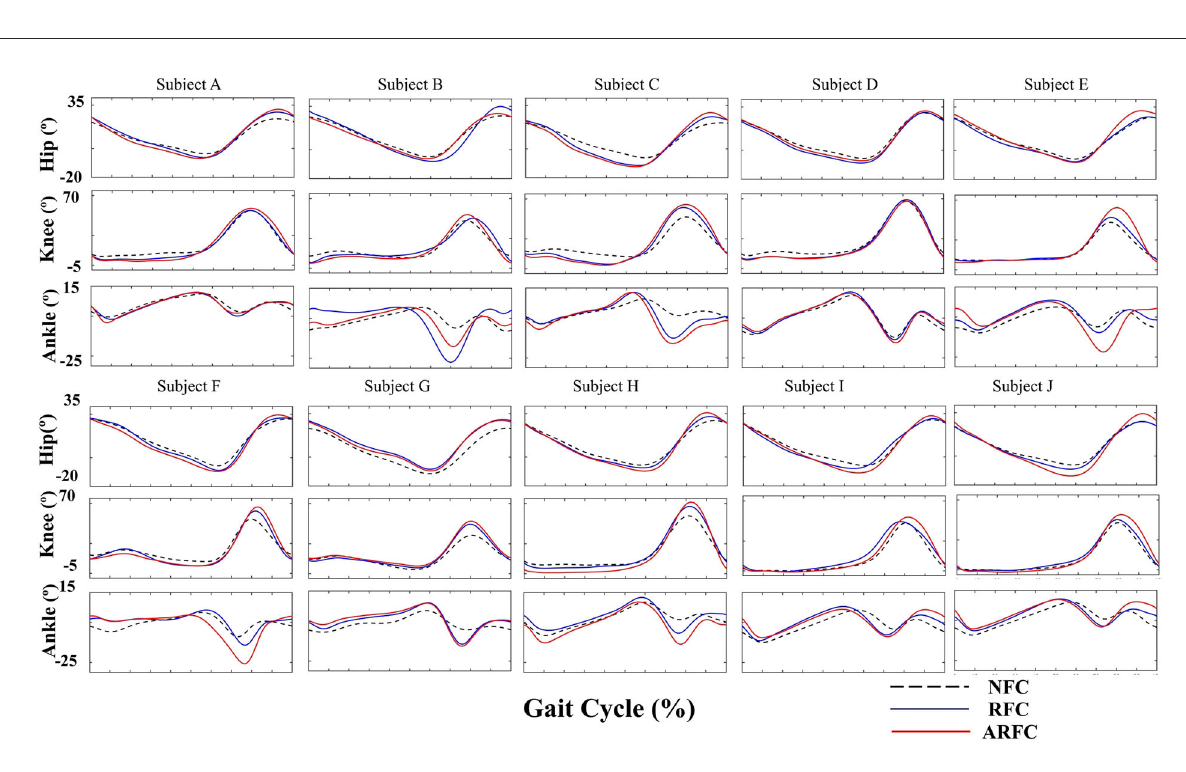
FES control method that employed a linear model with ILC to adjust the stimulation timing and intensity according to the average walking speed and the error between the actual maximum ankle dorsiflexion and target angle. Their proposed